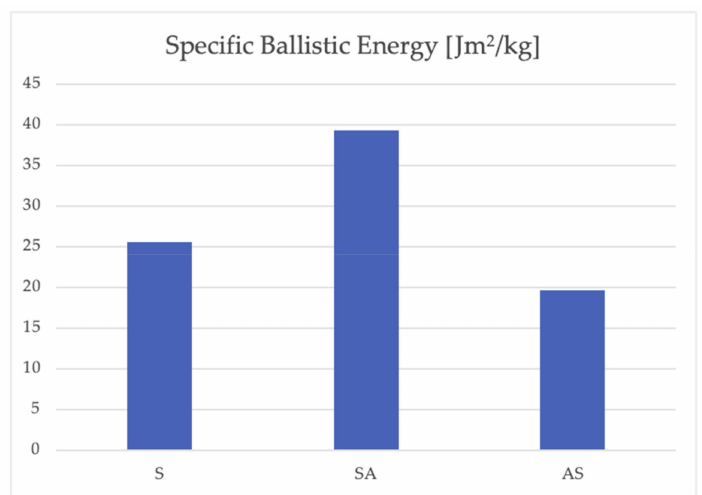
Figure 5. Specific ballistic energy for the three different